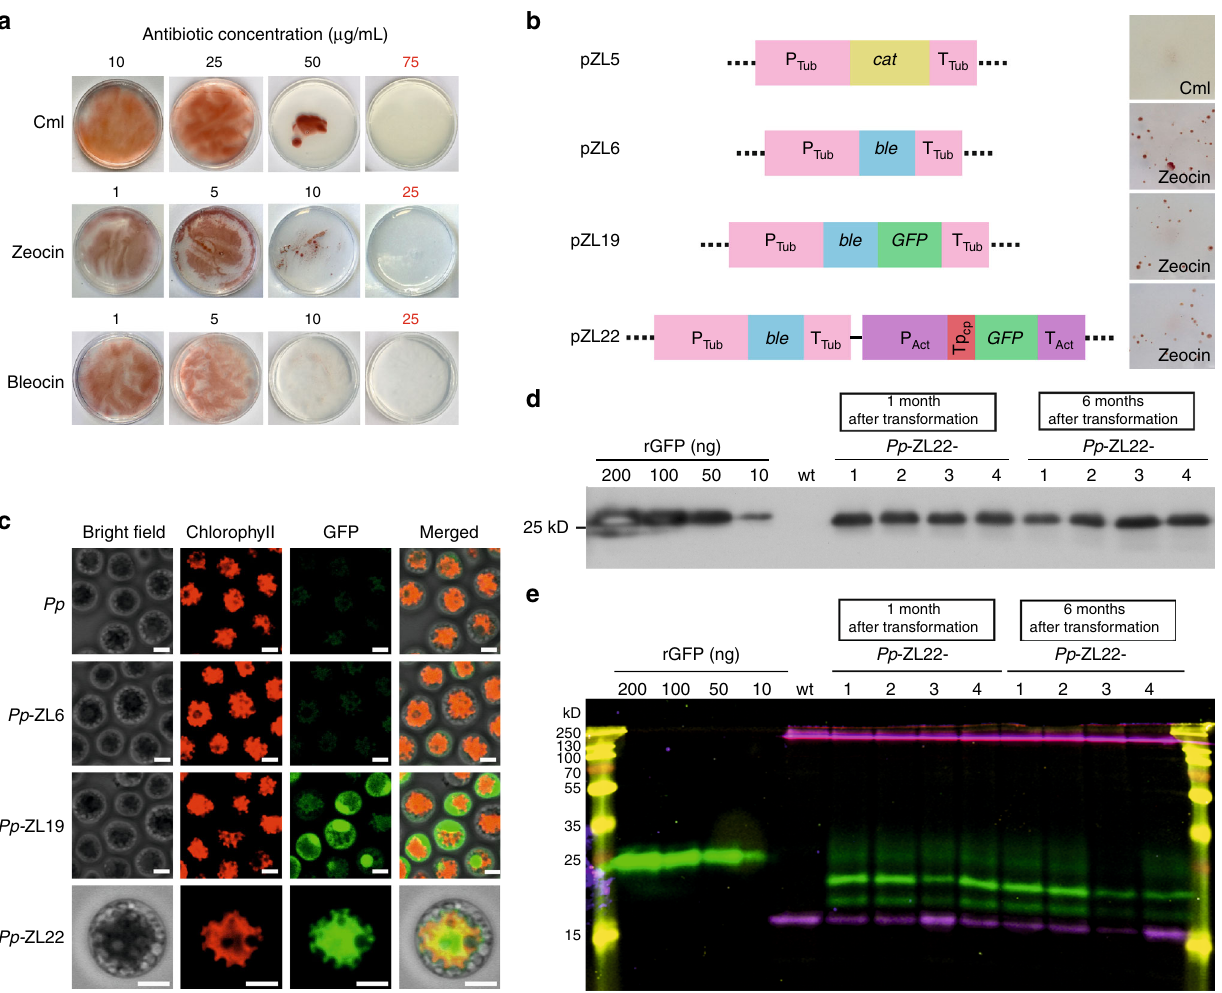
Fig. 1 Transformation of Porphyridium purpureum , targeting of GFP to different subcellular locations, and analysis of GFP accumulation in transgenic algal strains. a Antibiotic sensitivity tests for P. purpureum on ASW-containing agar-solidi fi ed medium. The algal cells are sensitive to the plastid translational inhibitor chloramphenicol (Cml) and the DNA-cleaving agents zeocin and bleocin. Red numbers denote the antibiotic concentrations used for selection of transformed cells. For tests of additional antibiotics and additional concentrations, see Supplementary Fig. 1. b Schematic representations of the expression constructs used for transformation and identi fi cation of transgenic colonies on selective medium. P promoter, T terminator, Tp transit peptide for protein import in plastids. c Analysis of GFP accumulation in transgenic red algae by confocal laser-scanning microscopy. Scale bars: 2.5 µ m. d Immunoblot analysis of GFP expression in red algae transformed with construct pZL22. 1 µ g total soluble protein was loaded in each lane. A dilution series of recombinant GFP (rGFP) was included for semiquantitative assessment of GFP accumulation. Protein accumulation is estimated to be approximately 5% of the total soluble protein (TSP). Protein accumulation levels were determined 1 and 6 months after transformation. The strains were grown in zeocin-containing medium. Wt wild type. e In-gel fl uorescence analysis of GFP expression. Samples of 1 µ g TSP extracted from transgenic algae transformed with plasmid pZL22 and a dilution series of rGFP were analyzed under non-denaturing electrophoresis conditions 13 followed by fl uorescence imaging. Shown is a merged image of three images taken with three different excitation wavelengths. GFP (green bands) was visualized by excitation at 488 nm, phycoerythrin (purple bands) was visualized at 532 nm, and the marker bands (yellow) at 633 nm. The individual images can be seen in Supplementary Fig.